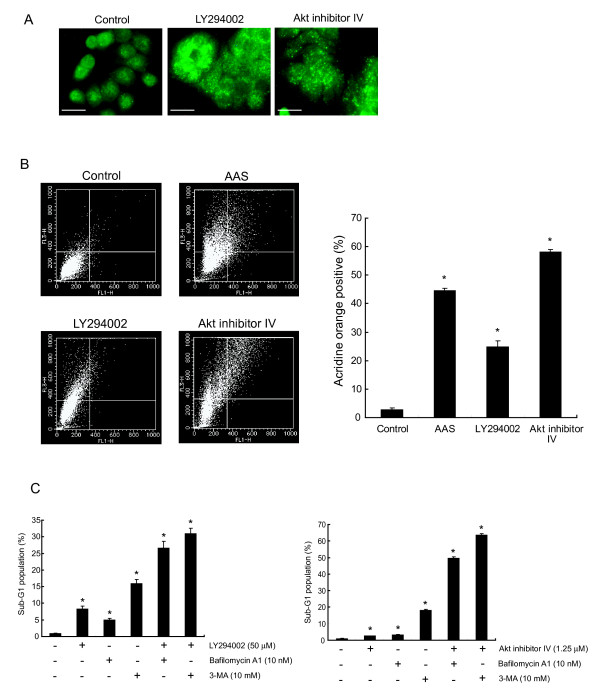
Effects of simultaneous inhibition of Akt activity and progression of autophagic process in HT-29 cells. A, HT-29 cells were exposed to DMSO (control), LY294002 (50 μmol/L) or Akt inhibitor IV (1.25 μmol/L) for 48 h and then subjected to immunofluorescent staining for LC3 as described in Materials and Methods. Bars, 20 μm. B, Quantification of acidic vesicular organelles by acridine orange staining using flow cytometry. HT-29 cells treated with DMSO (control), amino acid-deprived medium (AAS), LY294002 (50 μmol/L), or Akt inhibitor IV (1.25 μmol/L) for 48 h were stained with acridine orange and then the development of AVOs was analyzed as described in Materials and Methods. Left, FL1-H indicates the intensity of green fluorescence that is endogenous to the nucleus. FL3-H indicates the intensity of red fluorescence. Top of the grid was considered as AVOs. Right, Columns, mean (n = 3); bars, SD. *, P < 0.05, significantly different compared with the control. C, The sub-G1 population was quantified by flow cytometry after exposure to LY294002 (50 μmol/L) or Akt inhibitor IV (1.25 μmol/L) with or without bafilomycin A1 (10 nmol/L) or 3-MA (10 mmol/L) for 48 h. Columns, mean (n = 3); bars, SD. *, P < 0.05, significantly different compared with the control.